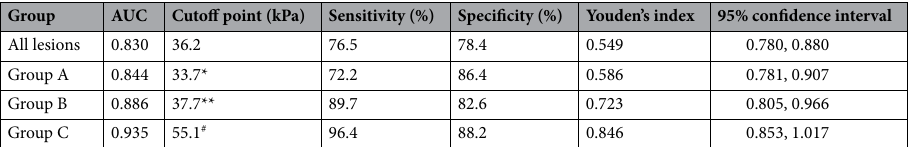
Table 3. Diagnostic performance parameters of Emax values in each group. *Indicates the AUC of Group A compared with that of all lesions, z = 0.34, p > 0.05. **Indicates the AUC of Group B compared with that of all lesions, z = 1.17, p > 0.05;# indicates the AUC of Group C compared with that of all lesions, z = 2.15, p <